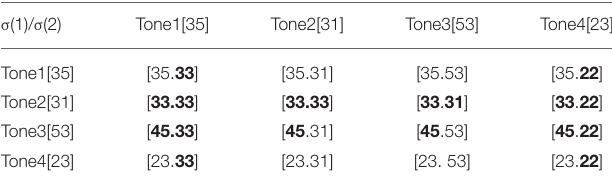
TABLE 4 | The relative pitch values of lexical tones in Chengdu disyllabic words. σ (1)/ σ